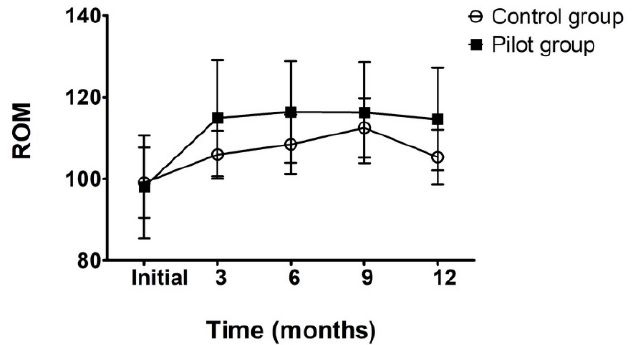
Figure 9. ROM evaluation of knee flexion in the PG ( n = 37) and the CG ( n = 15). Statistically, the within-group ROM effect size Ω ROM was 16.62 ± 6.24 in the PG versus 8.75 ± 8.27 in CG, with p < within-group ROM effect size Ω ROM was 16.62 ± 6.24 in the PG versus 8.75 ± 8.27 in CG, with 0.0004. p <